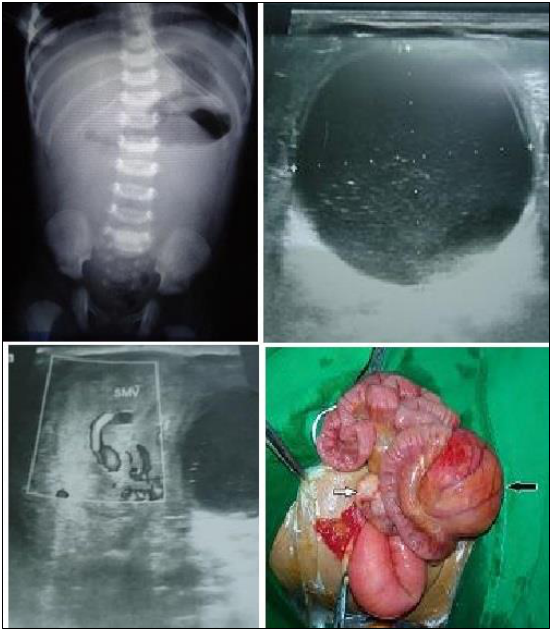
Figure 1: Showing plain x-ray, ultrasound abdomen, Doppler USG, and operative picture of jejunal duplication cyst (black arrow).The sub-hepatic mobile cecum and appendix suggested midgut malrotation (white